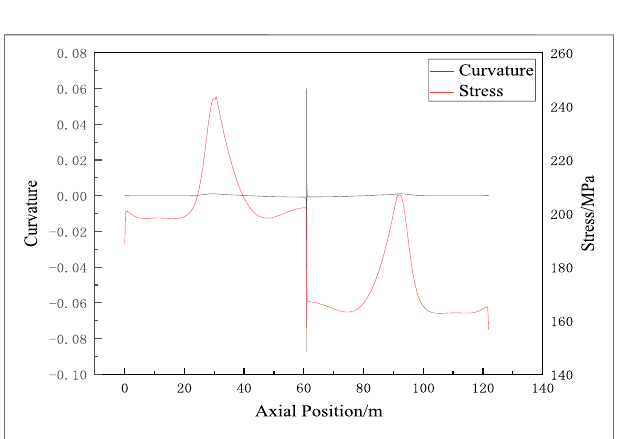
FIGURE 17 | Curvature and strain